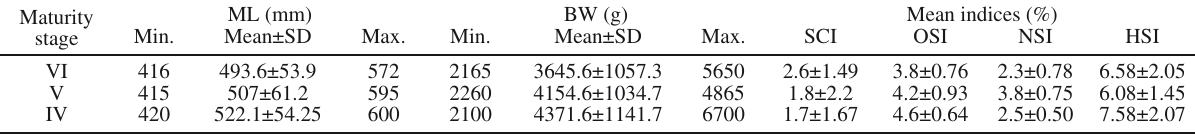
Fig. 4. – Somatic indices of the squid Ommastrephes bartramii at the three stages of maturity (late-maturing, mature, and spawning state) collected in February 1992. BW, body weight; ML, mantle length; NSI, nidamental gland somatic index; ODSI, oviduct somatic index; OSI, ovary somatic index; SCI, stomach Table 2. – Mean±SD and range values for the size (mantle length, ML) and weight (body weight, BW) of female Ommastrephes bartramii . Mean values are shown for the stomach content index (SCI), ovary somatic index (OSI), nidamental gland somatic index (NSI), and Hepato somatic index (HSI).